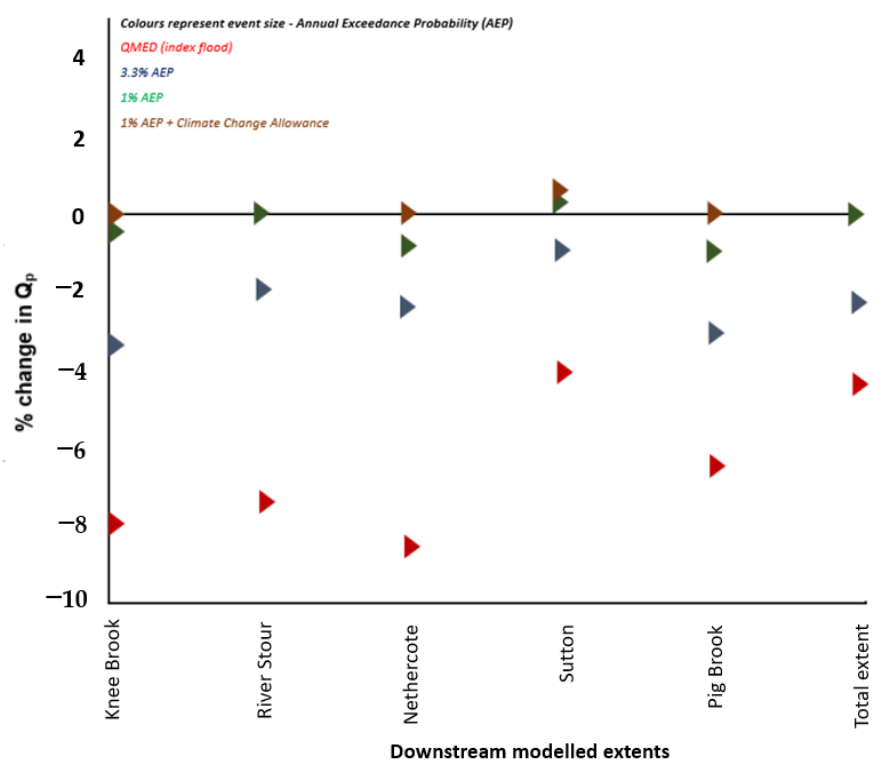
Figure 8. Downstream change ( Δ ) in peak discharge (Qp) across modelled domains to different sized events.